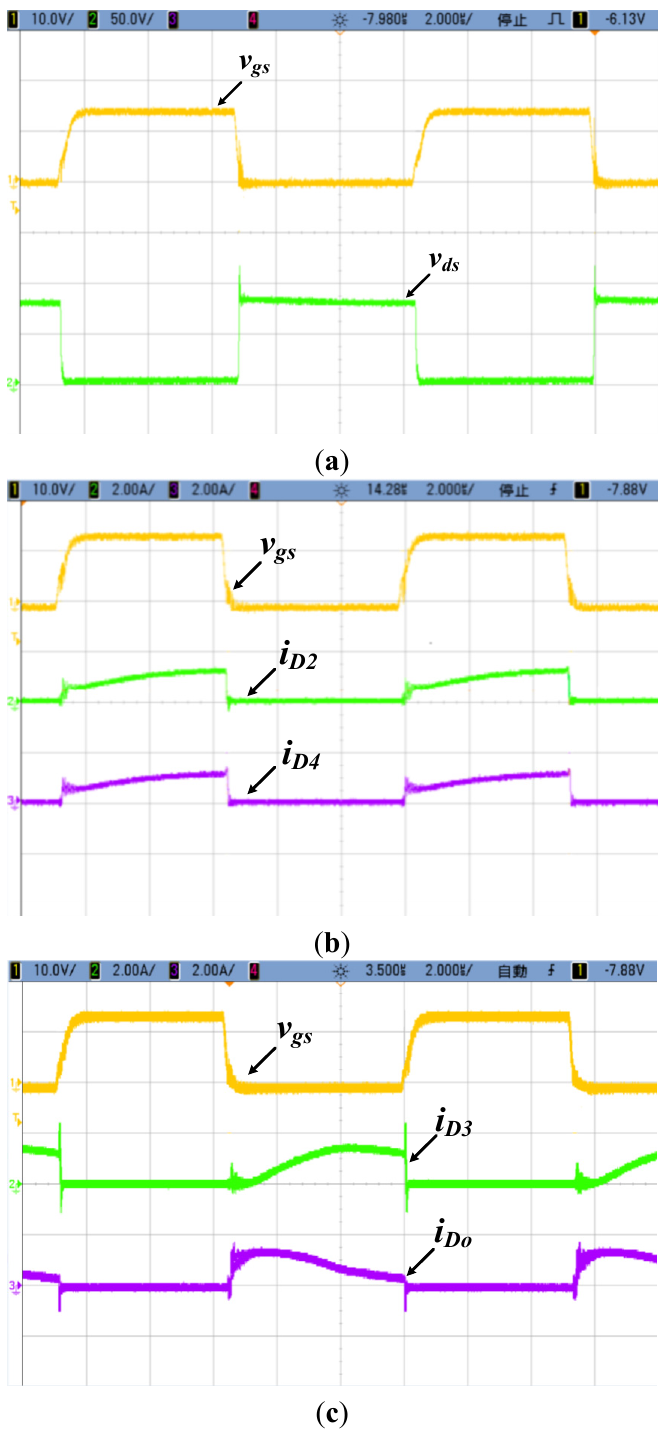
Figure 10 is the measured efficiency of the prototype. The maximum efficiency is up to 97.1% and an efficiency of 94.9% is achieved at full load.